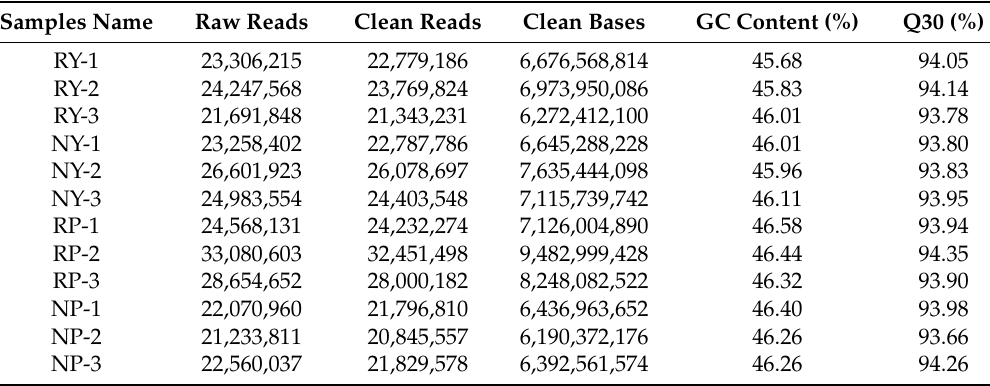
Table 2. Summary of sequencing data.